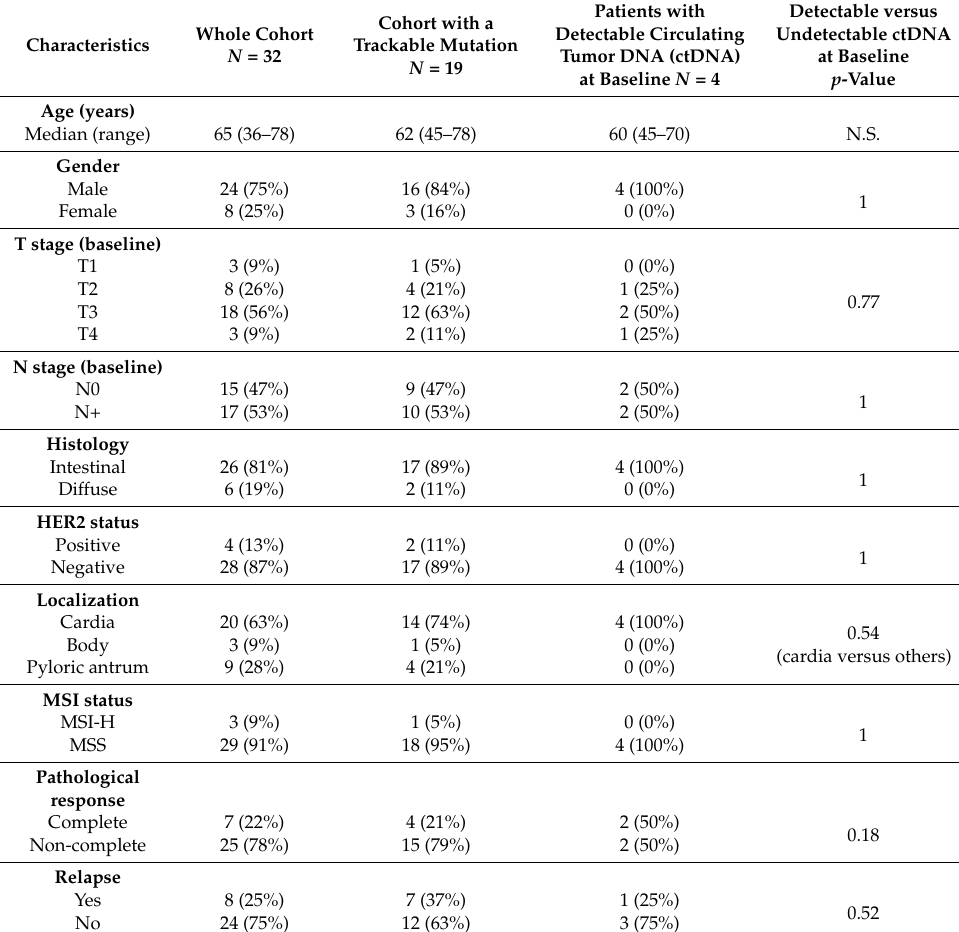
Table 1. Patient characteristics.